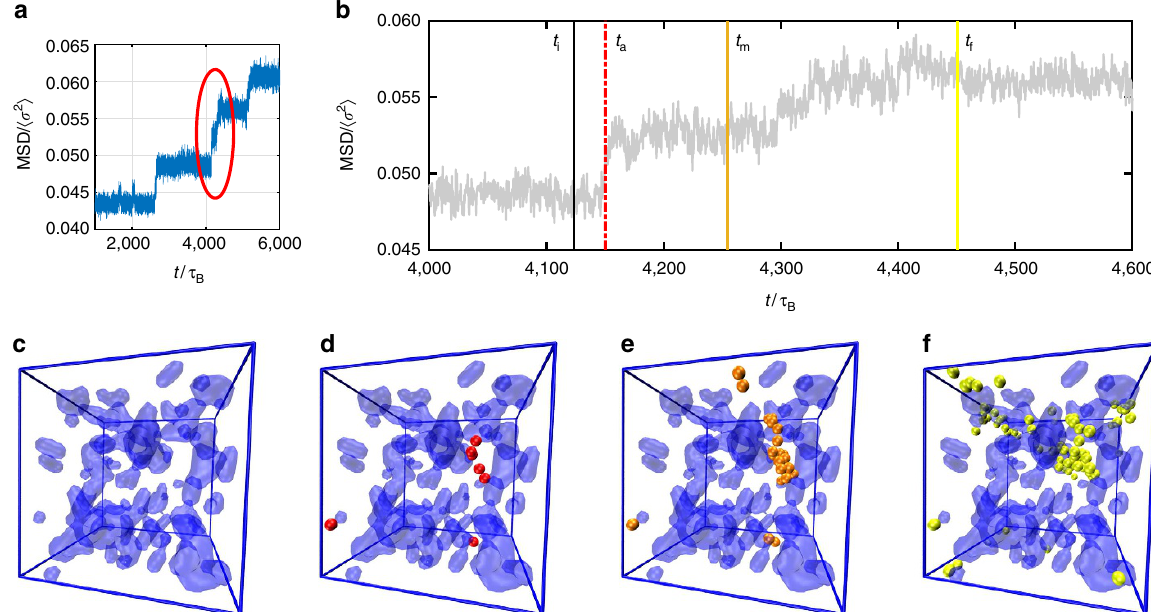
Figure 1 | Avalanche over time seen in an ageing system at / ¼ 0.65. ( a ) MSD over all particles from a time t 0 . We can see distinct avalanche events that happen intermittently. The circled event is the same as that shown in c – f . ( b ) MSD over all particles from a time t 0 , focused on the avalanche event circled in a . Times t i , t a , t m and t f correspond to snapshots c – f , respectively. ( c – f ) Progression of the circled avalanche event in a . Blue shaded regions are regions where Q 6 4 0.25. We only display particles which have been displaced more than s l /3 since snapshot c in each panel. We can see the number of these particles increase progressively. Particles displayed at d can be regarded as AIs, whereas particles appearing later on are APs. All other particles are not displayed. Despite the step-like appearance of the MSD in b , it is reasonable to assume that this is one collective event, as we can see in c – f